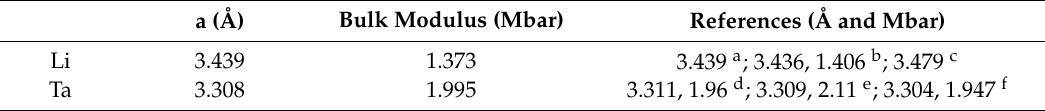
Table 1. The optimized lattice parameters and bulk modulus for the BCC-Li and BCC-Ta.